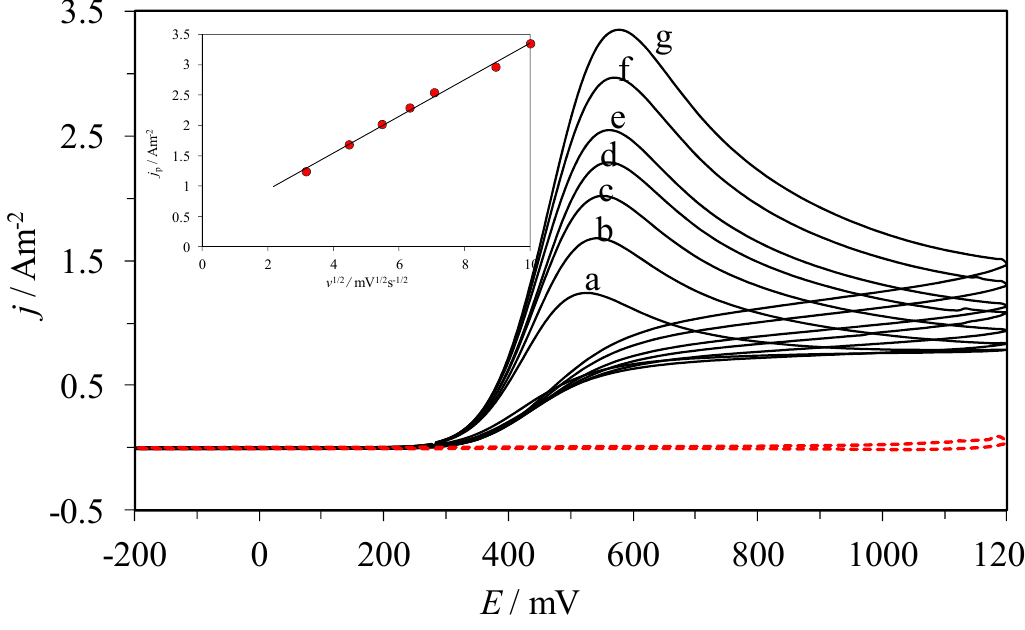
Figure 2. Family of cyclic voltammograms recorded in the system CPE/0.1 M NaCl, 1 mM AA at pH 3.0, at the different scan rates, ν , indicated: (a) 10, (b) 20, (c) 30, (d) 40, (e) 50, (f) 80, (g) 100, mV s − 1 . The inset shows the variation of the oxidation peak’s current , as a function of ν 1/2 , where the dots (  ) correspond to the experimental data and density, j p the line to the linear fitting. The broken line corresponds to the cyclic voltammogram recorded in the same system but in the absence of